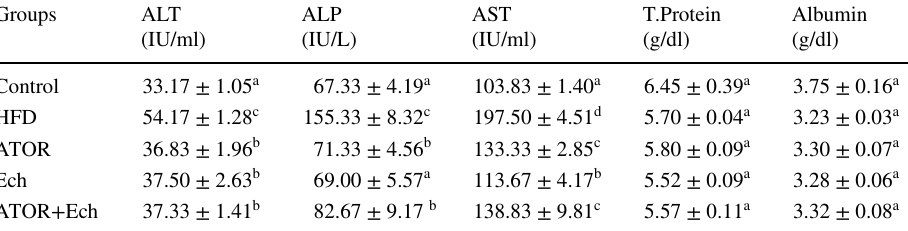
Table 2 Effect of Ech and ATOR on liver biomarkers in hyperlipidemic